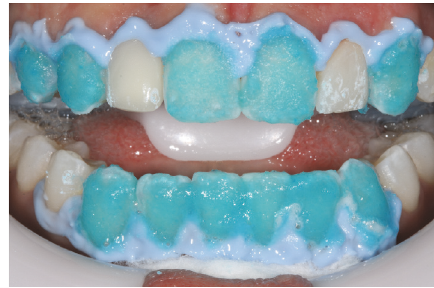
Figure 5: In-office bleaching with hydrogen